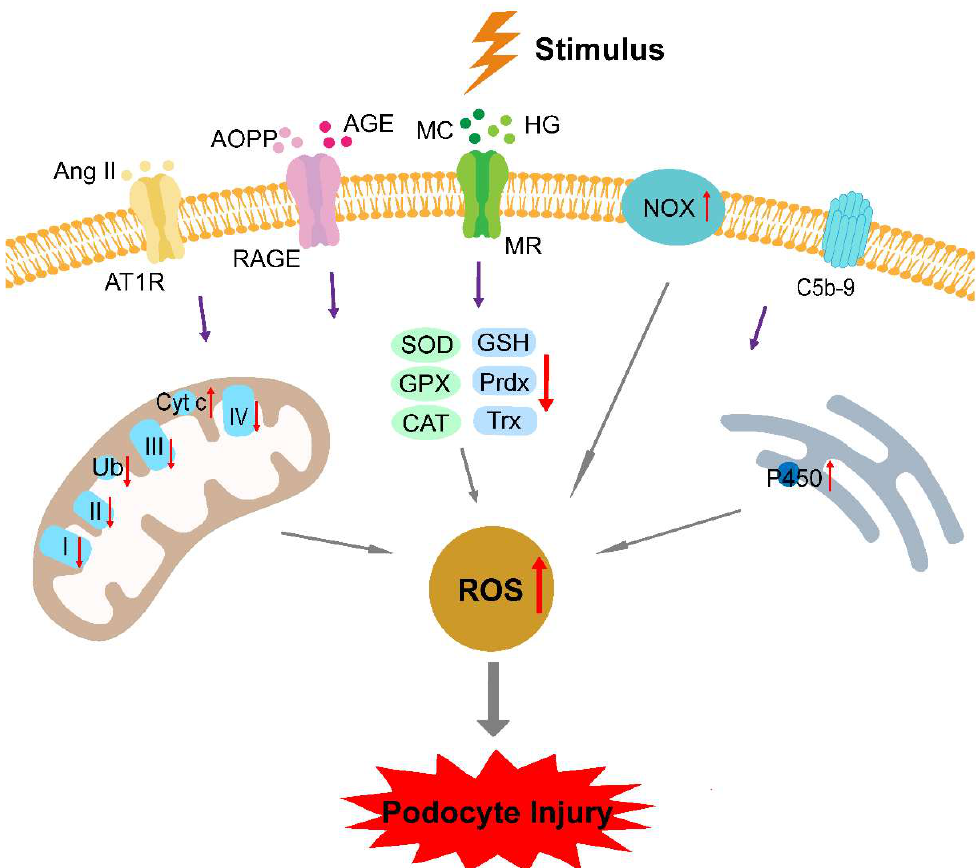
Figure 1. Oxidative stress plays a significant role in the pathogenesis of podocytopathies. Various harmful stimuli, such as puromycin aminonucleoside, immune complexes, HG, and Ang II, upregulate NOX, Cyt C, and P450, and downregulate mitochondrial respiration chain complexes (complex I, II, III, and IV), Ub, and antioxidant defense systems, including SOD, GPX, CAT, GSH, Prdx, and Trx. Excessive ROS accumulation in the podocyte causes damage to DNA, lipids, and proteins, and activates downstream signaling pathways, leading to podocyte foot process effacement, loss, and detachment, with clinical presentations of proteinuria and proteinuria-related symptoms. HG, high glucose; Ang II, angiotensin II; AT1R, angiotensin II type 1 receptor; AOPPs, advanced oxidation protein products; AGEs, advanced glycation end-products; RAGE, receptor of advanced glycation end-products; MC, mineralocorticoid; MR, mineralocorticoid receptor; C5b-9, C5b-9 membrane attack complex; NOX, NADPH oxidase; I, complex I; II, complex II; III, complex III; IV, complex IV; Ub, quinone; Cyt c, cytochrome c; SOD, superoxide dismutase; GPX, glutathione peroxidase; CAT, catalase; GSH, glutathione; Prdx, peroxiredoxin; Trx, thioredoxin; P450, cytochrome P450; and ROS, reactive oxygen species.